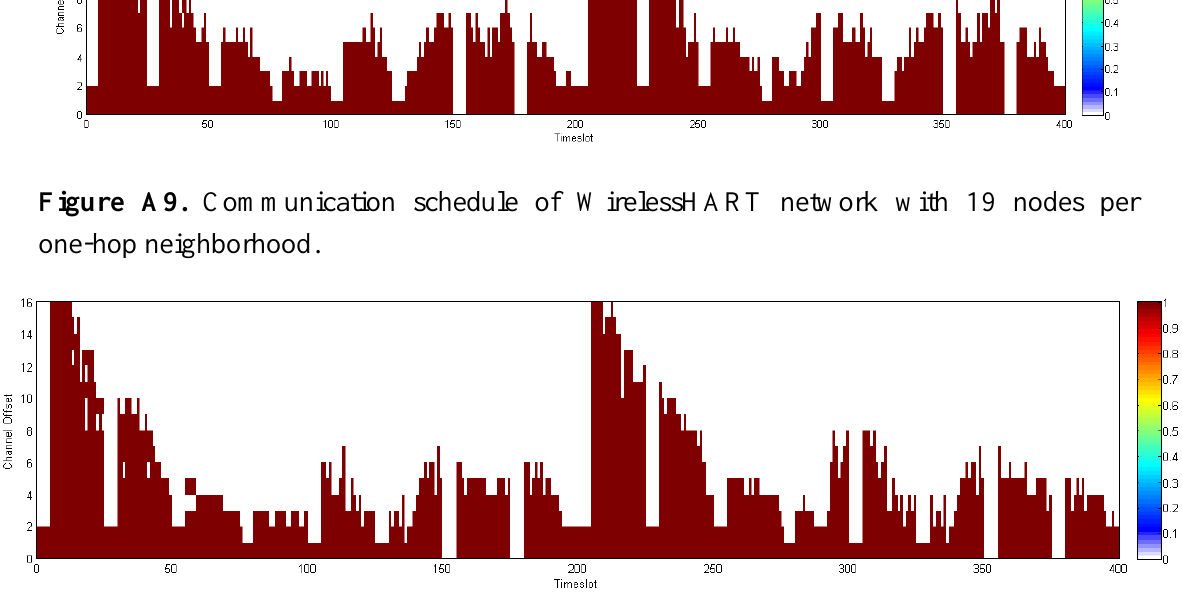
Figure A10. Communication schedule of WirelessHART network with 21 nodes per one-hop